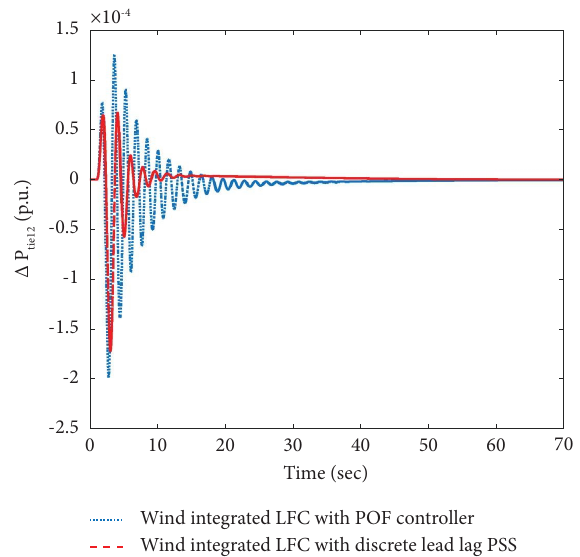
Figure 10: Tie line power deviation Δ P tie12 (p.u.) with respect to time (sec) for the wind-integrated LFC system having the discrete lead-lag-based PSS and with the POF controller ( N � 2, τ � 0.04, and Δ �